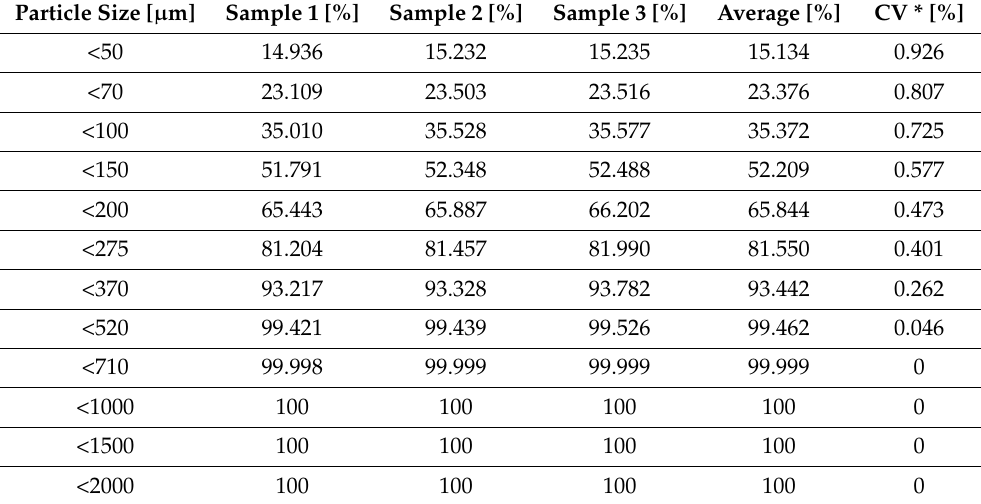
Table 4. Results of the first particle size distribution analysis in terms of cumulative frequency.